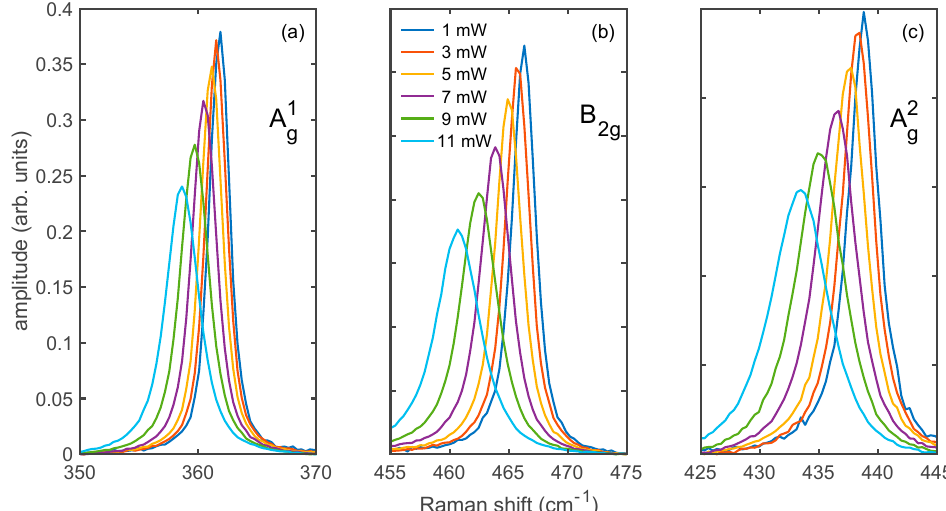
Figure 2. Normalized Raman bands A 1 g ( a ), B 2 g ( b ), and A 2 g ( c ) of a flake of black phosphorus on gold as a function of the increasing incident power.